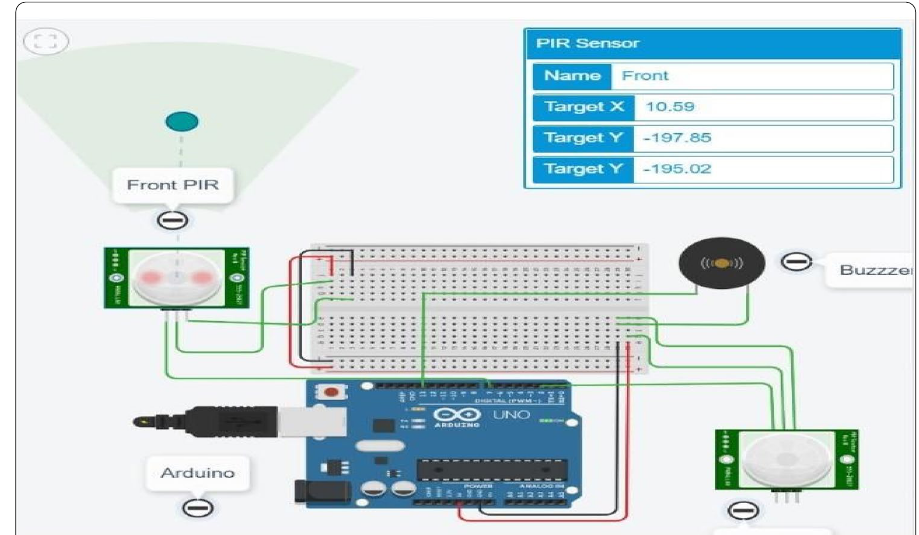
Fig. 8 Output at an instance when object detected at front PIR